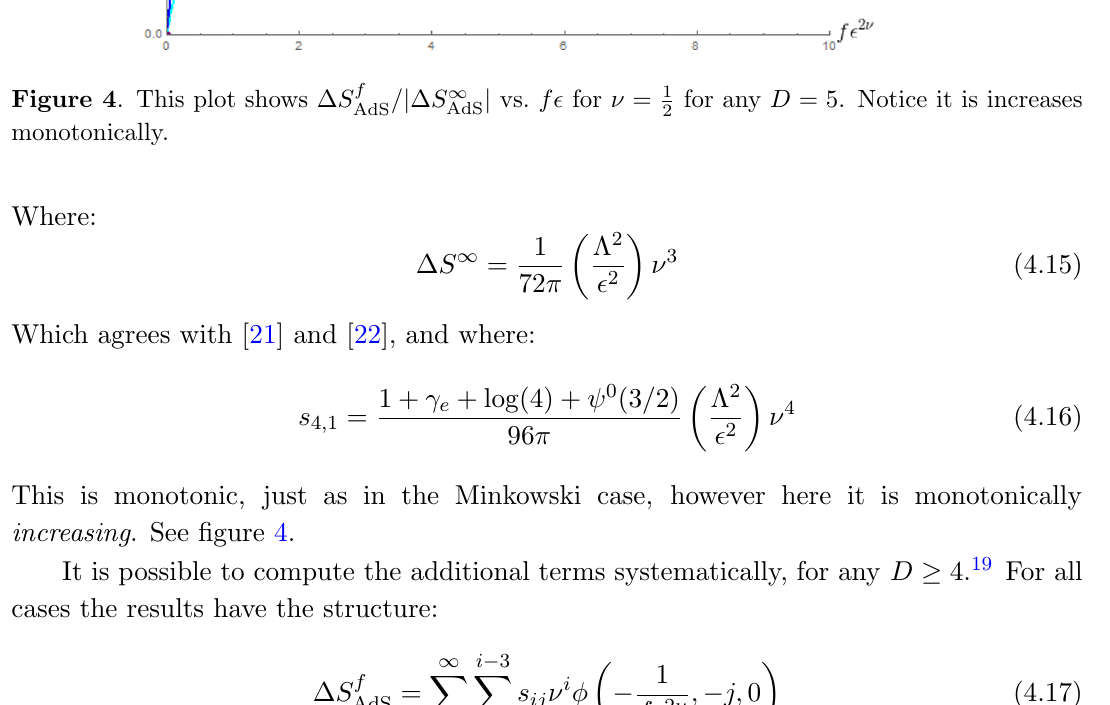
j vs. f(cid:15) for (cid:23) = 1